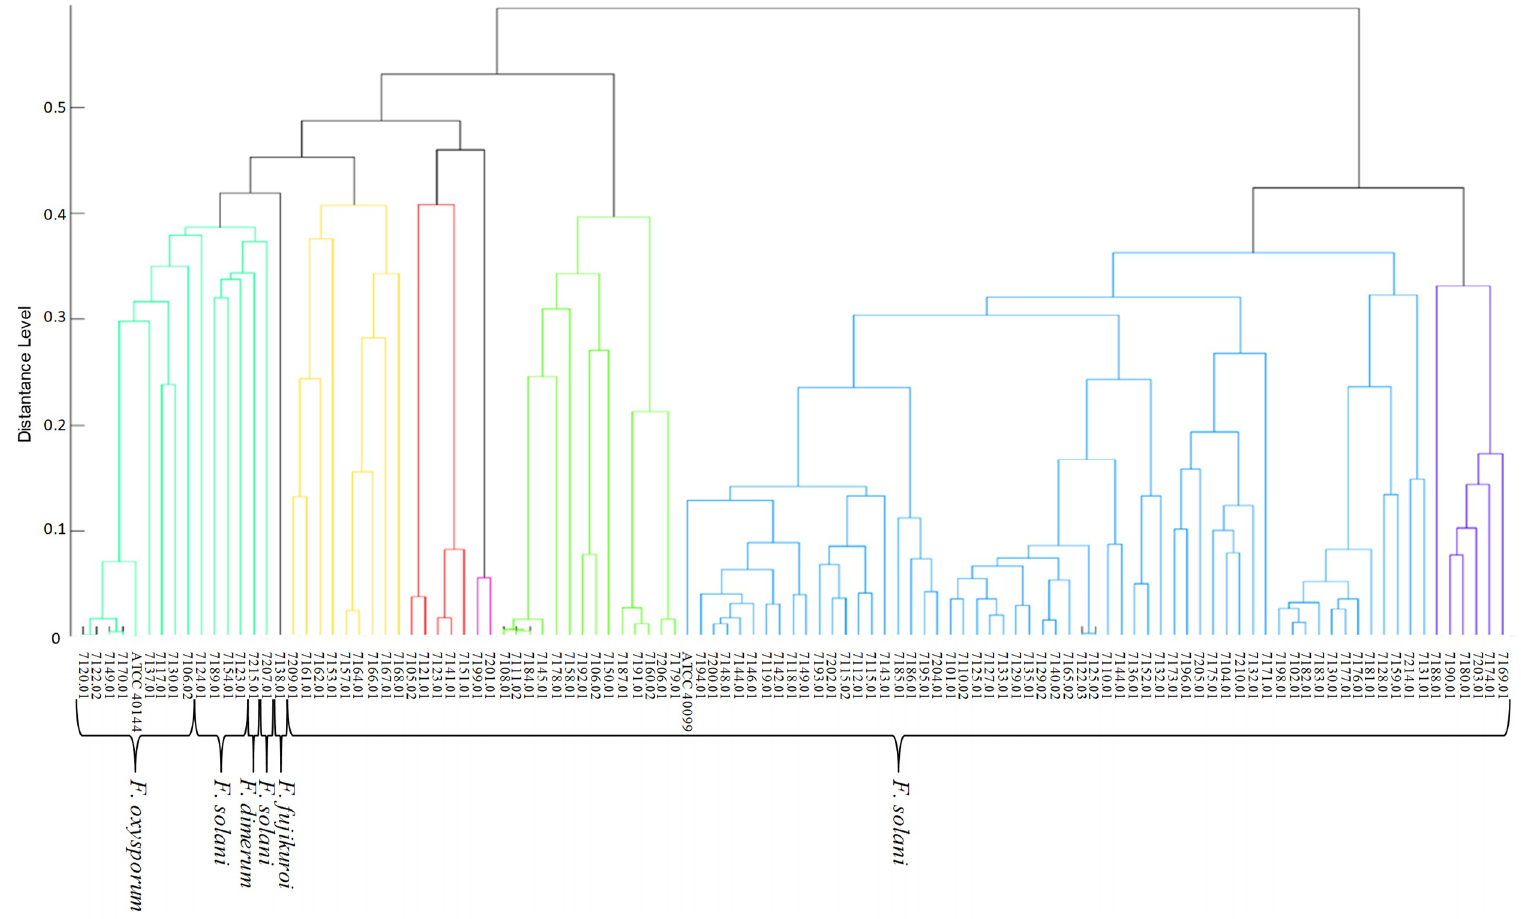
Figure 4. Phenotypic dendrogram based on MALDI-TOF MS spectra, obtained in the range from 2000 to 20,000, for Fusarium species complexes. Dendrogram of spectral similarity were obtained by agglomerative clustering algorithm with the software MALDI Biotyper Compass 4.1. C to G—mass spectra profiles of FSSC clinical isolates and control strain.